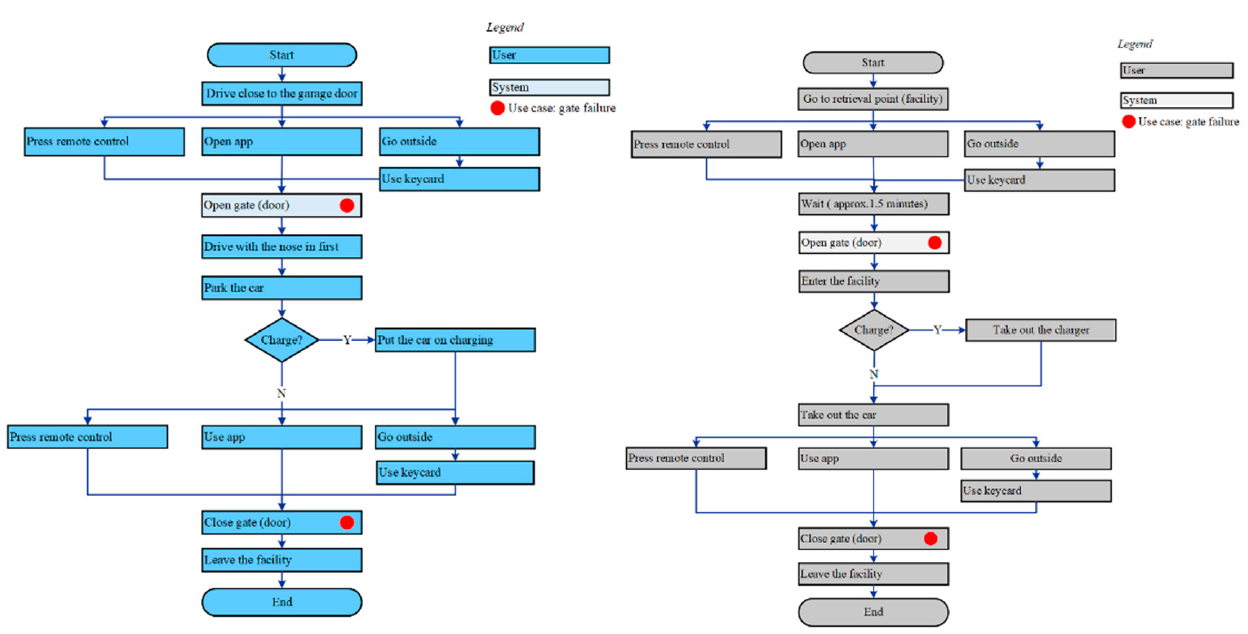
Figure 9. Workflow for car entry ( left ) and car retrieval ( right ). Functional flow model: We developed a functional flow model for the maintenance task of fixing failures in general, including the gate. This model indicates the SOI’s down- time due to unscheduled maintenance tasks, as depicted in Figure 10.